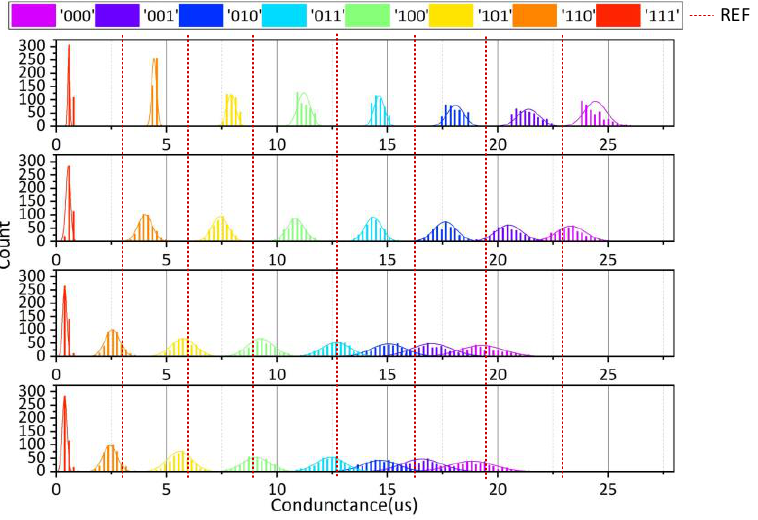
Figure 10. The conductance drift of the conventional 1T1R structure in 8 states. With the traditional 1T1R structure, the method of bisection is usually used to read the storage cell. For the reference cell, we usually take half of the maximum resistance and the minimum resistance. When the resistance of storage cell is larger than the reference cell, data “1” is output, and when the storage cell is smaller than the reference cell, data “0” is output. It could be noticed that the conductance of each state becomes lower, resulting in more overlap between adjacent